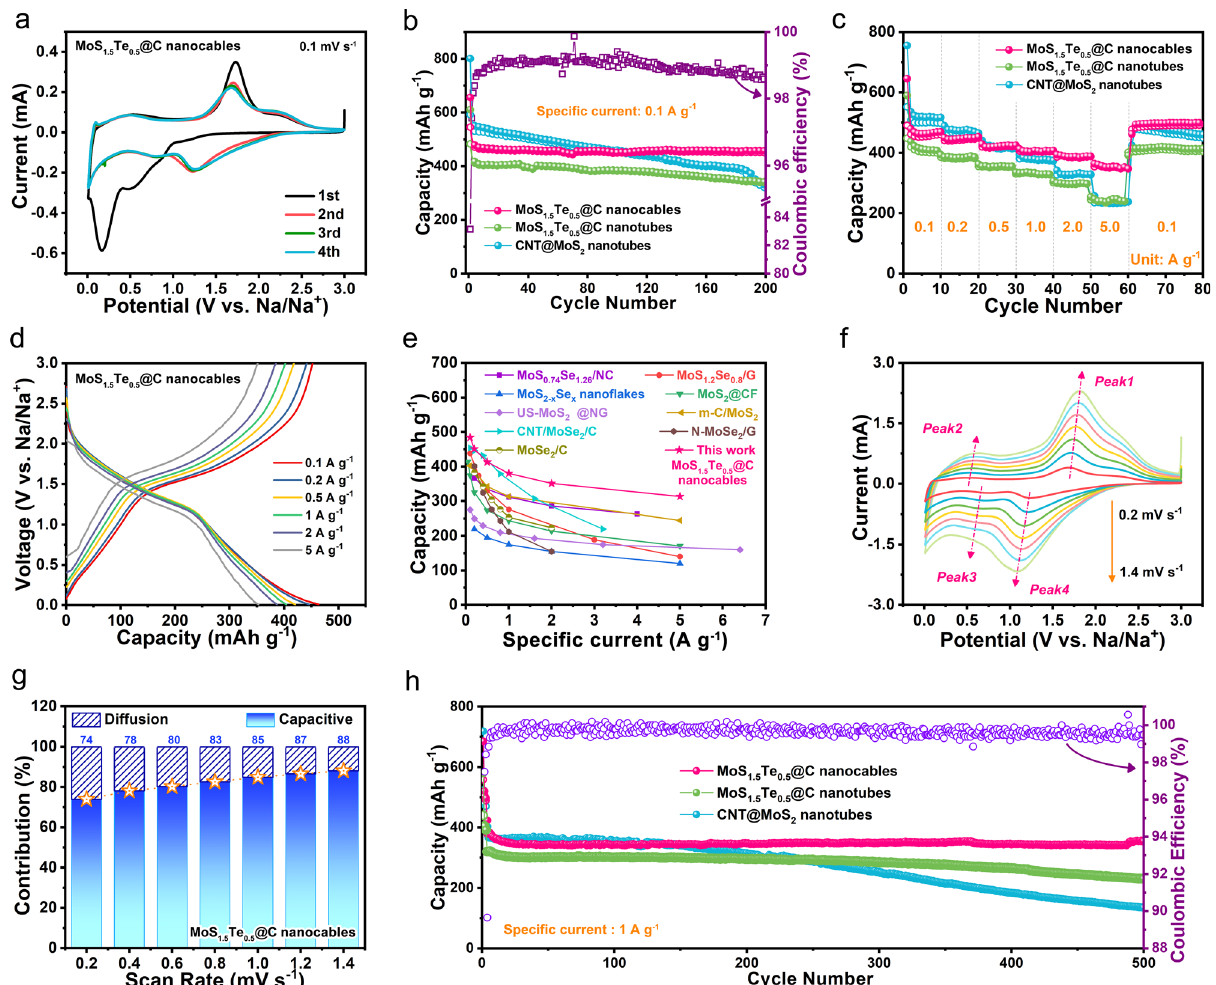
Fig. 3 Electrochemical characterizations of the Mo-containing active materials. a CV curves of MoS 1.5 Te 0.5 @C nanocables electrode at a sweep rate of 0.1 mV s − 1 . b Cycling performance, c rate capabilities test, and d corresponding charge/discharge curves at various speci fi c currents for the three Mo- containing active materials using the 1 M NaPF 6 in EC/EMC/DMC (1:1:1, by volume) electrolyte solution at 25 °C. e Comparison of sodium-ion storage performance of MoS 1.5 Te 0.5 @C nanocables electrode with previously reported Mo-based electrode materials. f CV curves at different scan rates and g the percentages of capacitive and diffusion-controlled capacities at different scan rates in the MoS 1.5 Te 0.5 @C nanocables electrode. h Comparison of long-term cycling stability at 1.0 A g − 1 for the three different Mo-containing active materials